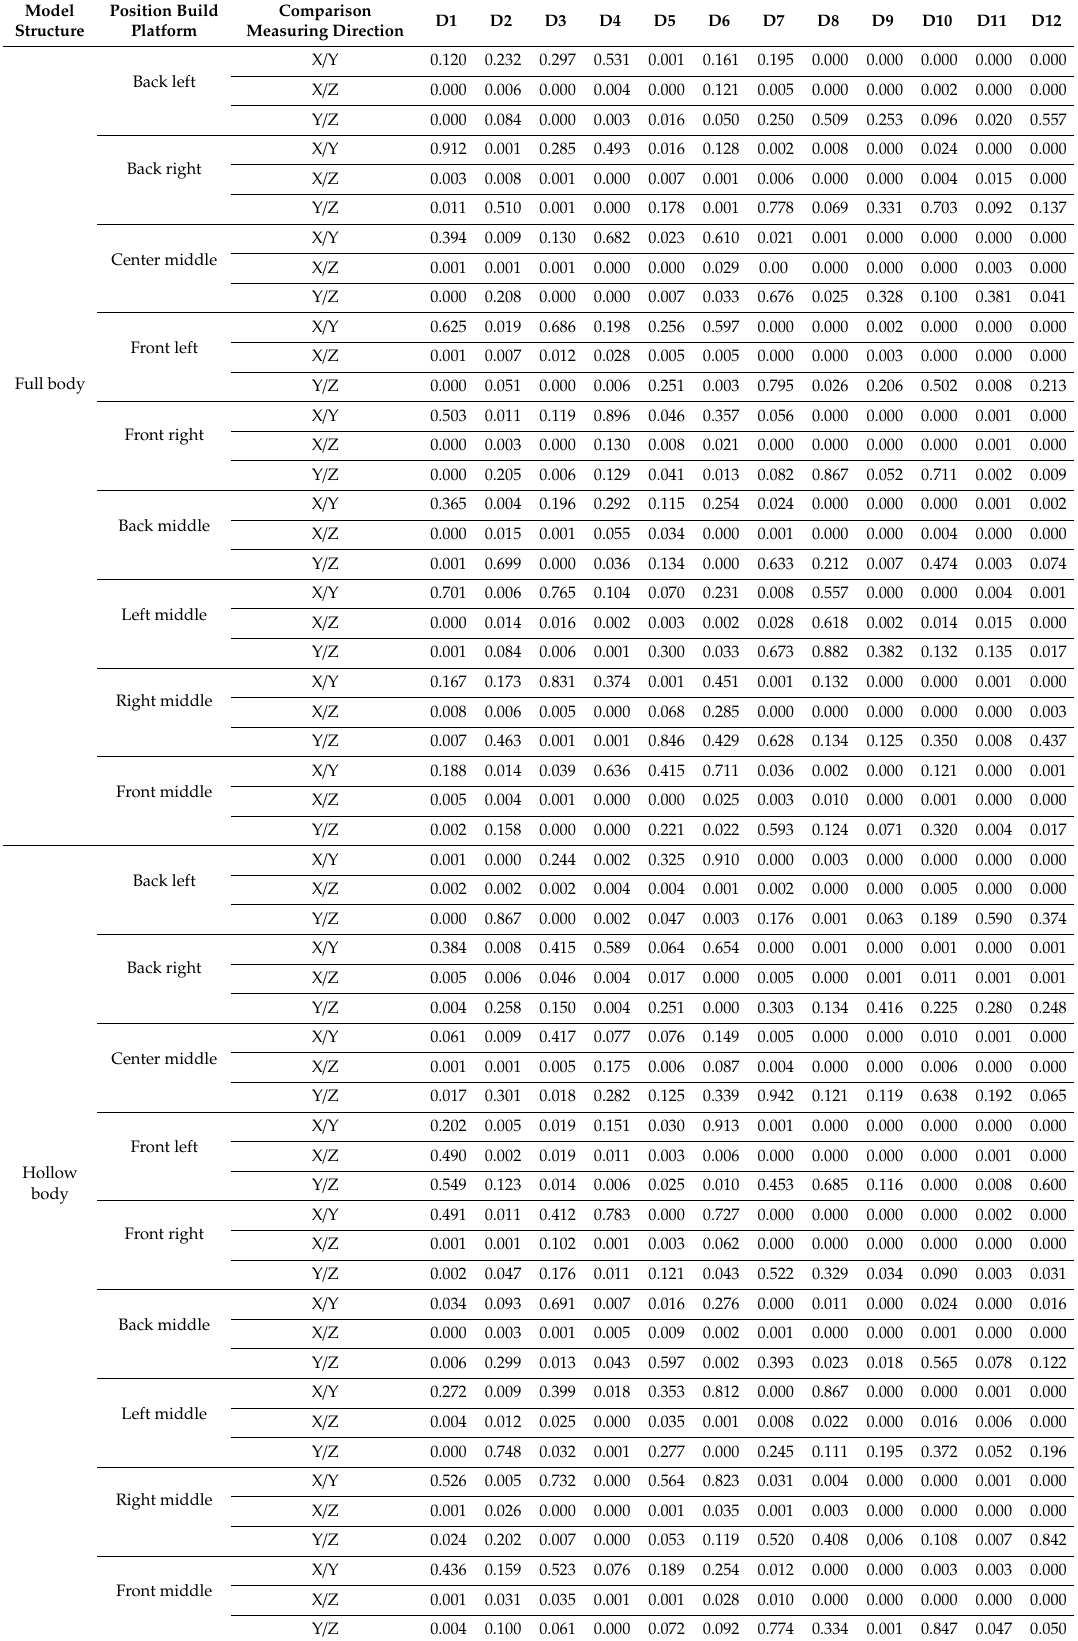
Table 4. Significances of roughness value Ra comparisons among measurement